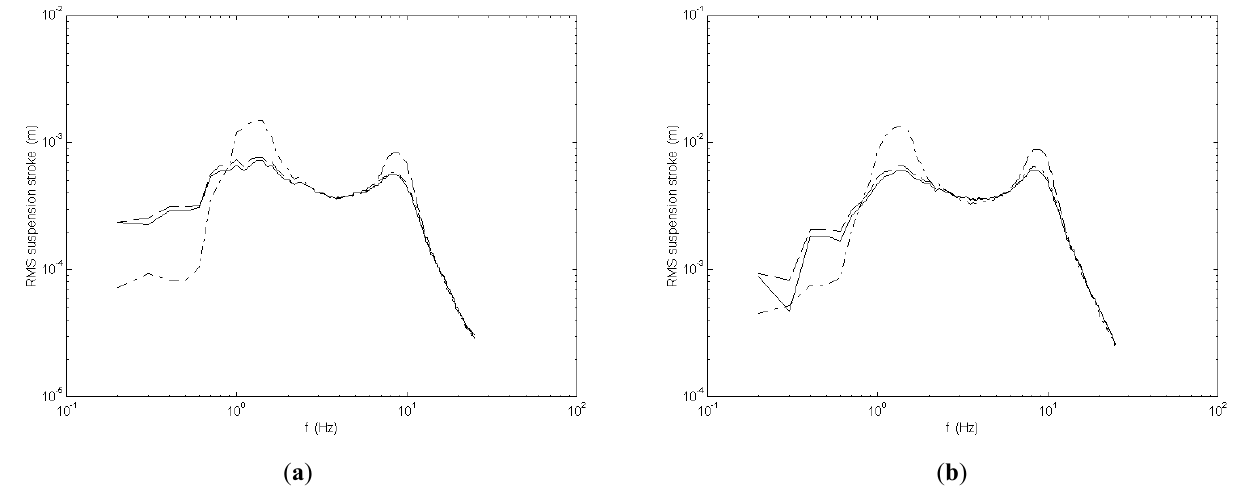
Figure 7. RMS of suspension stroke. ( a ) smooth road; ( b ) rough road.